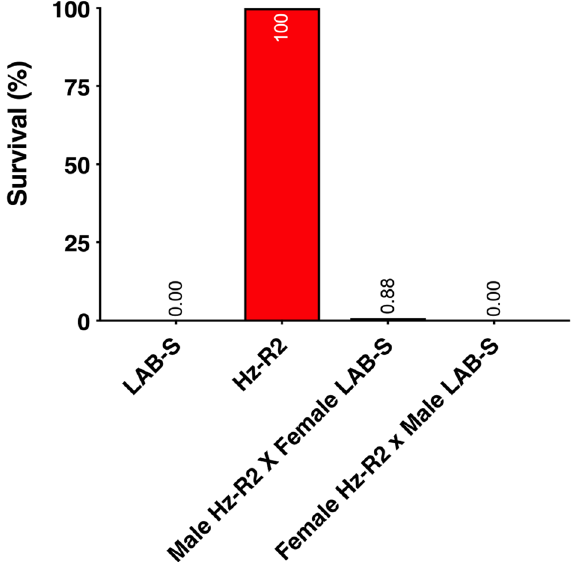
Figure 3. Survival of H. zea larvae from Hz-R2, its parent susceptible strain (LAB-S), and their F 1 progeny from mass crosses. Mean corrected survival was determined using diet overlay bioassays with 1 μg Cry2Ab per cm 2 diet for LAB-S, Hz-R2 (G 4 ), and the two reciprocal crosses (n = 130 per